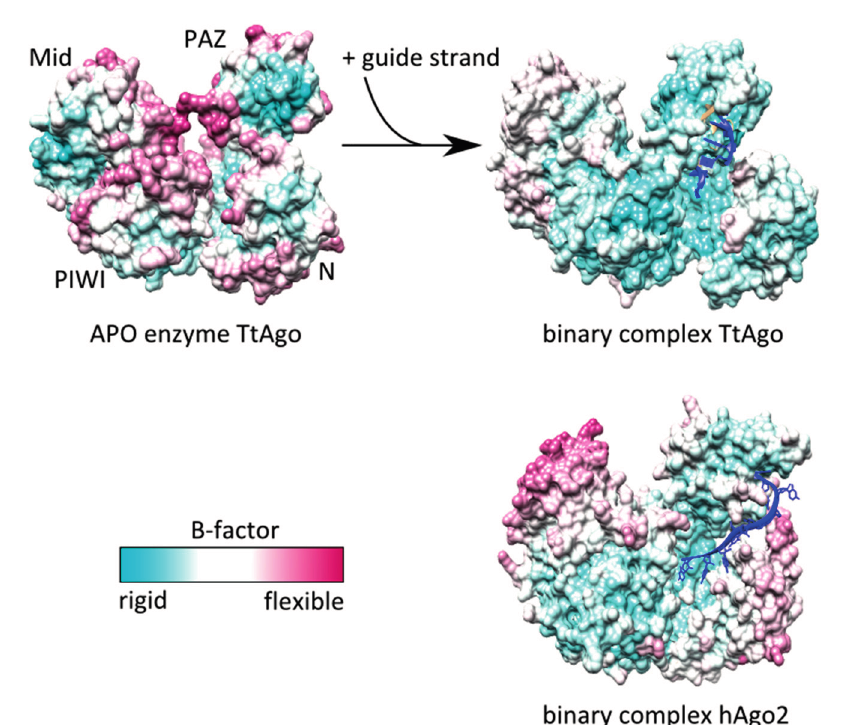
Figure 3. B-factor colouring of a TtAgo APO enzyme, binary TtAgo-guide and hAgo2-guide complexes. B-factor colouring was conducted using Chimera 1.7. APO-enzyme (pdb: 3DLB), binary complex TtAgo (pdb: 3DLH) and hAgo2 (pdb: